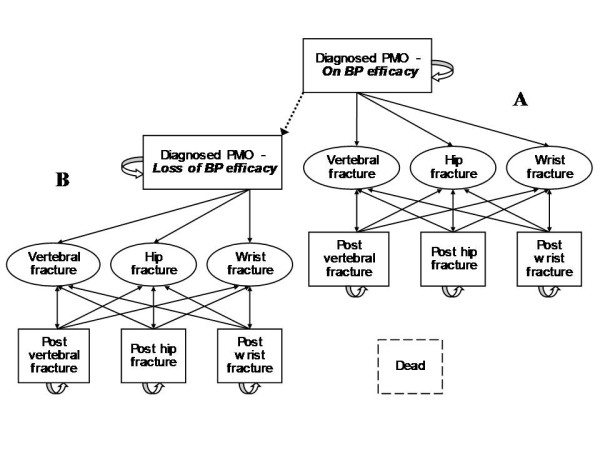
Markov model structure.